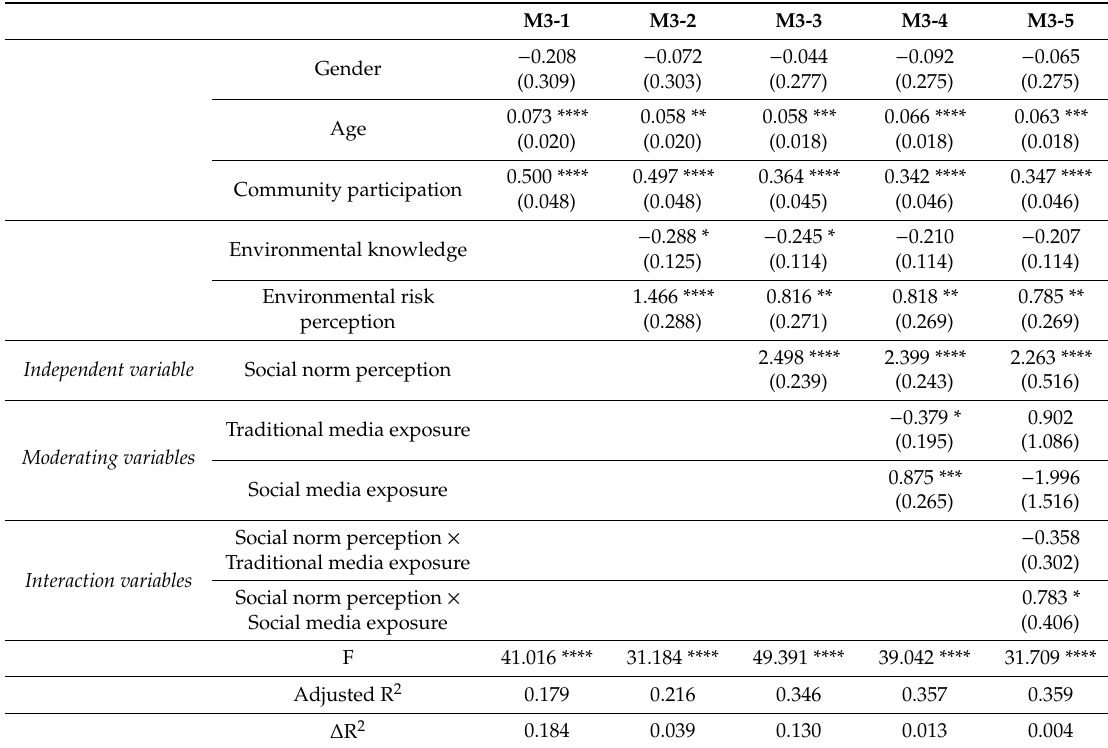
Table3. Multiple regressionanalysis ofthe influence ofnorm perception